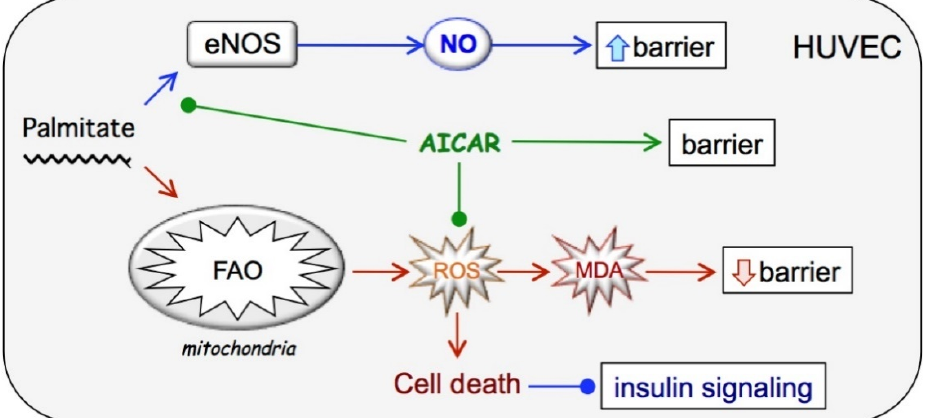
Figure 7. Proposed mechanism of chronic palmitate and AICAR action on endothelial cells. See text for details.